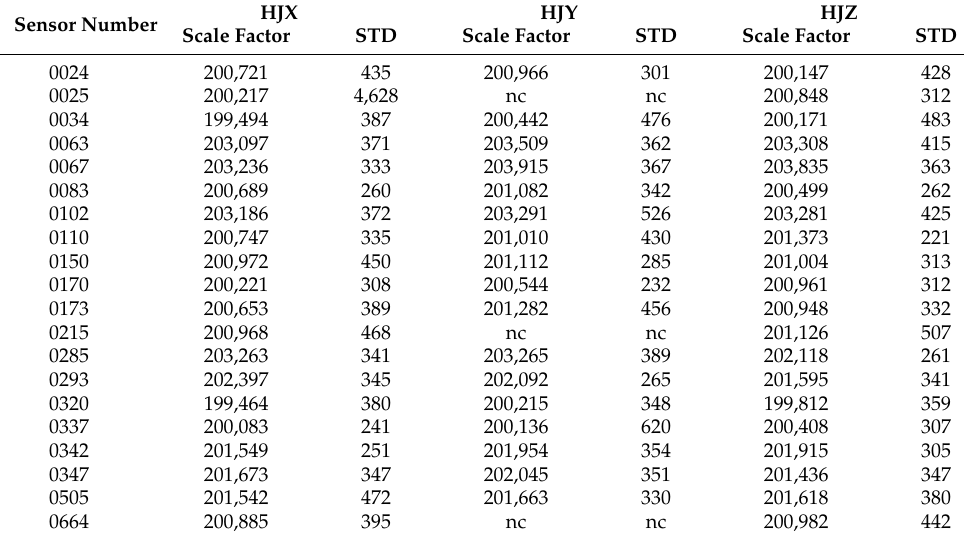
Table 2. The scale factor and the standard deviation of the scale factor for each FOG. ‘nc’ denotes “not connected” indicating that these components were not operational. All have units of ( countsrad − 1 s )